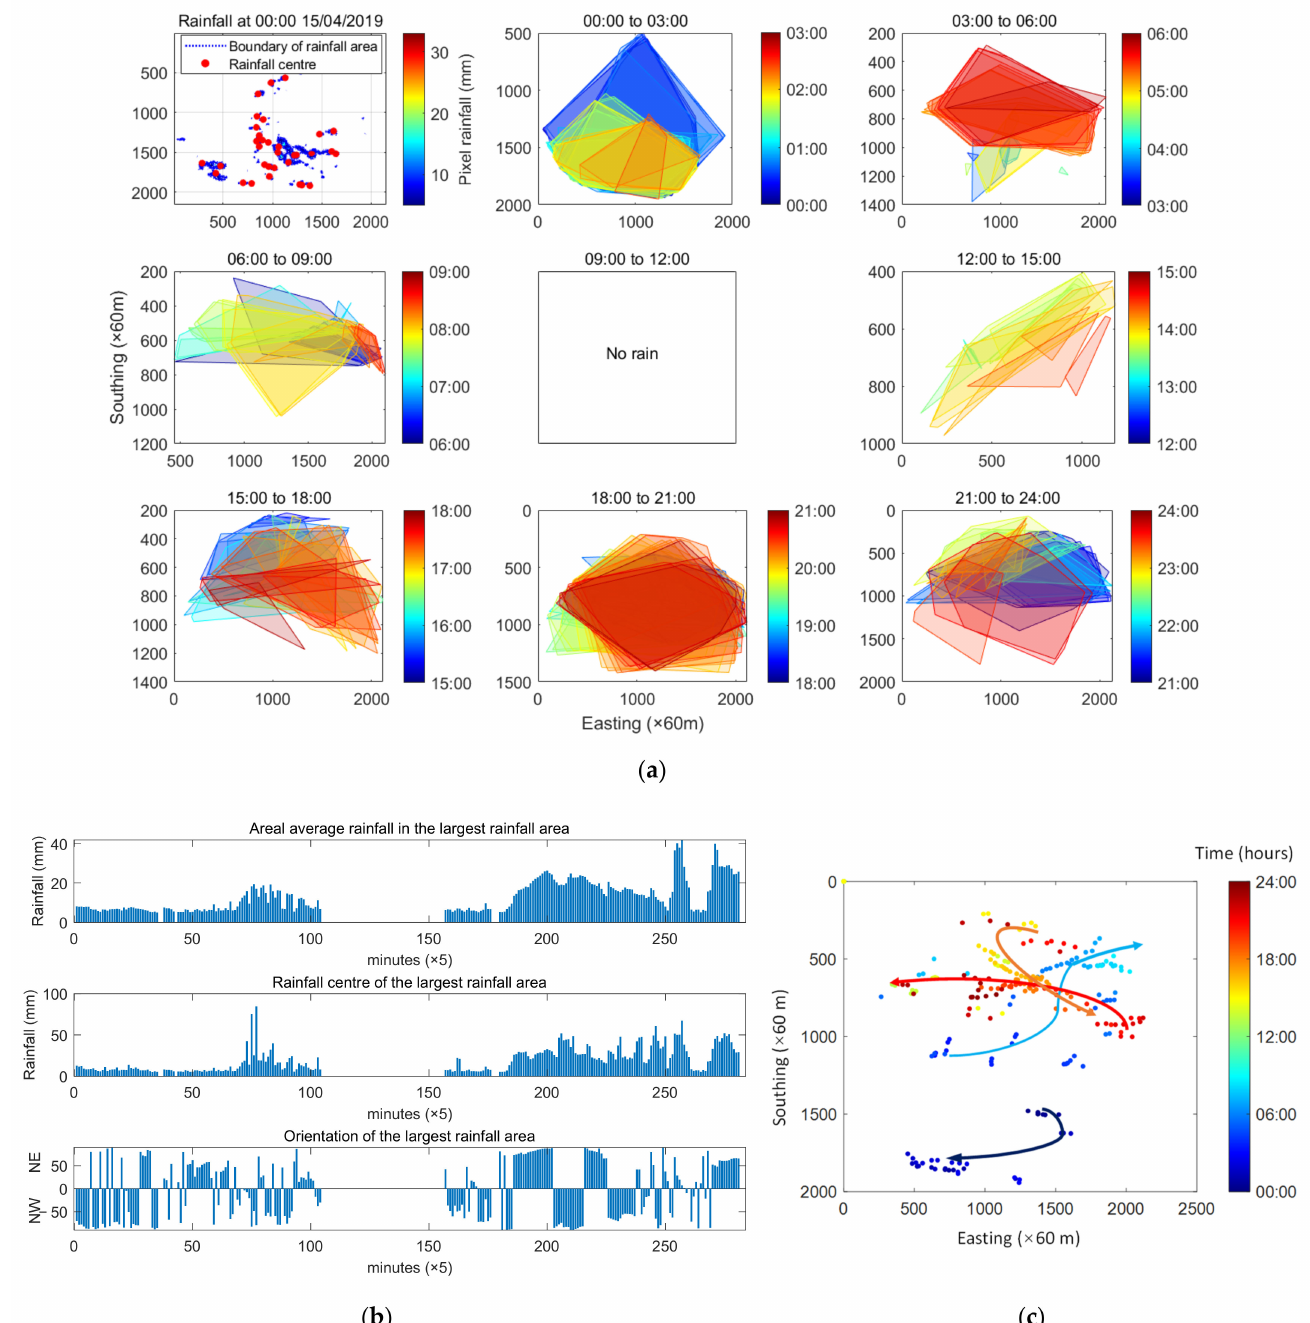
Figure 6. Monitor the rainfall changes in Guangdong in 24 h: the changes in the scattered area of rainfall centres ( a ), characteristics of the largest rainfall area ( b ) and the moving track of four rainfall systems ( c